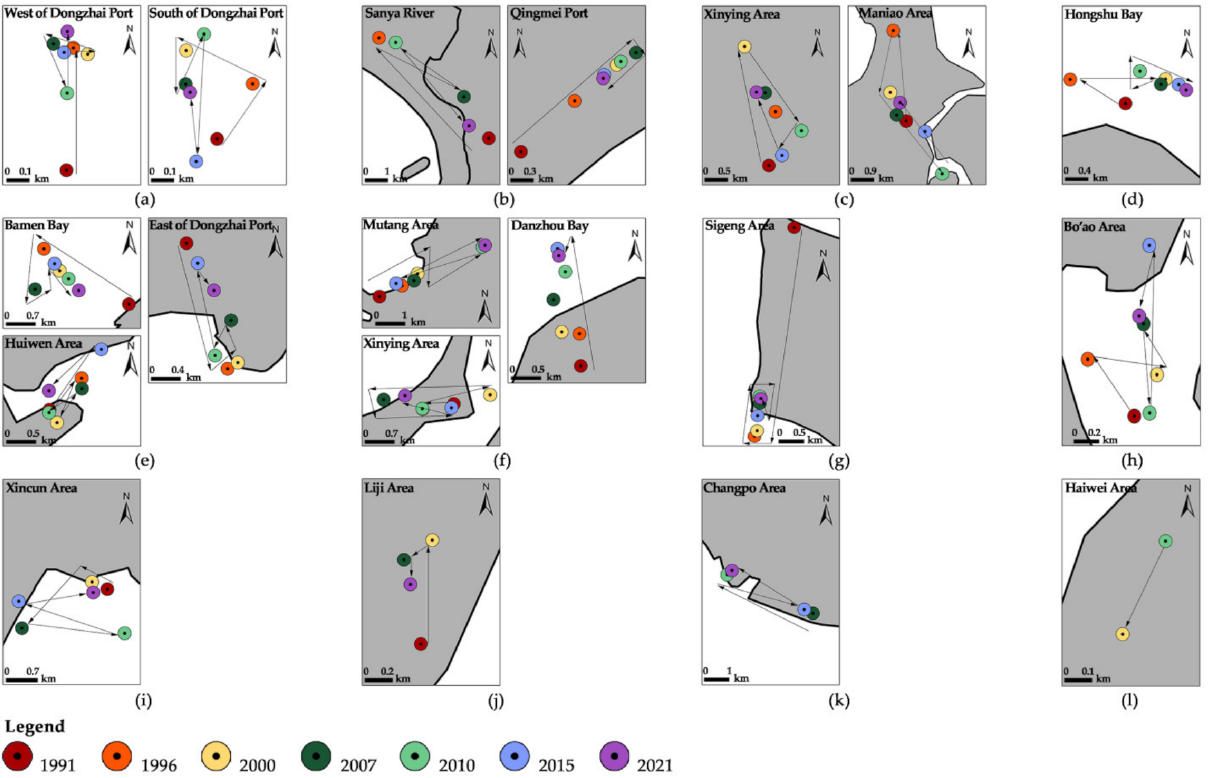
Figure 9. Mass center offset maps of mangrove forests across the Hainan Island for ( a ) Haikou, ( b ) Sanya, ( c ) Lingao, ( d ) Chengmai, ( e ) Wenchang, ( f ) Danzhou, ( g ) Dongfang, ( h ) Qionghai, ( i ) Lingshui, ( j ) Wanning, ( k ) Ledong, and ( l ) Changjiang.